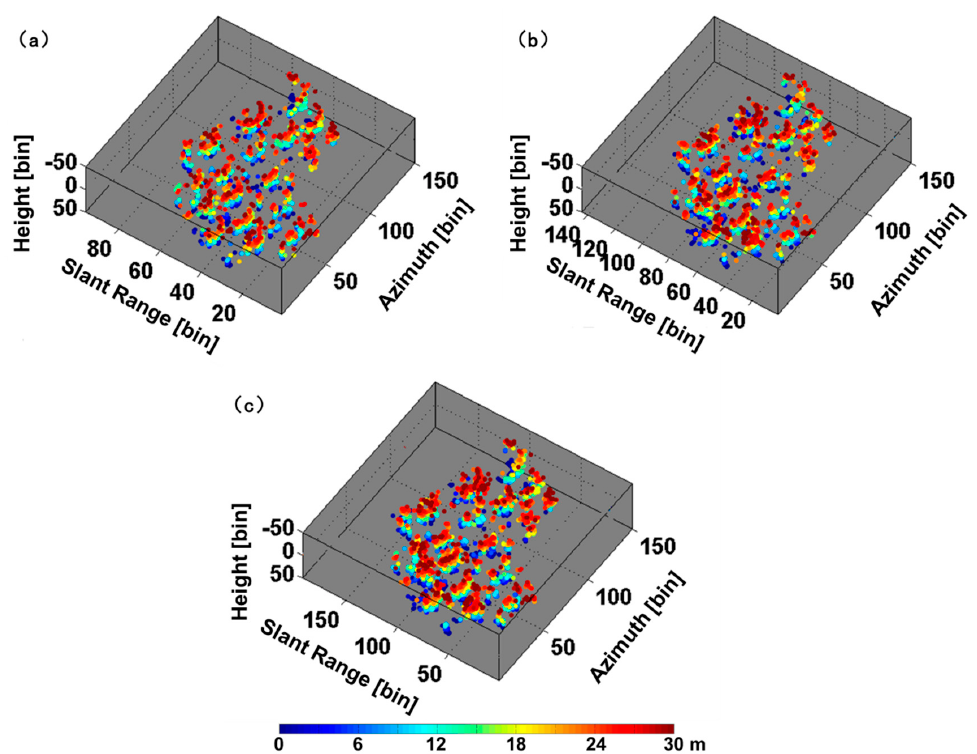
Figure 13. Three-dimensional visualization of the building zone of the scatterers reconstructed with SAR tomography, after coordinate transformation from range to ground distance, obtained with ( a ) CS 1D TomoSAR method; ( b ) CS-2D-TomoSAR with the range resolution enhanced 1.5 times; and ( c ) CS-2D-TomoSAR with the range resolution enhanced two-fold. The color is associated to the estimated height.